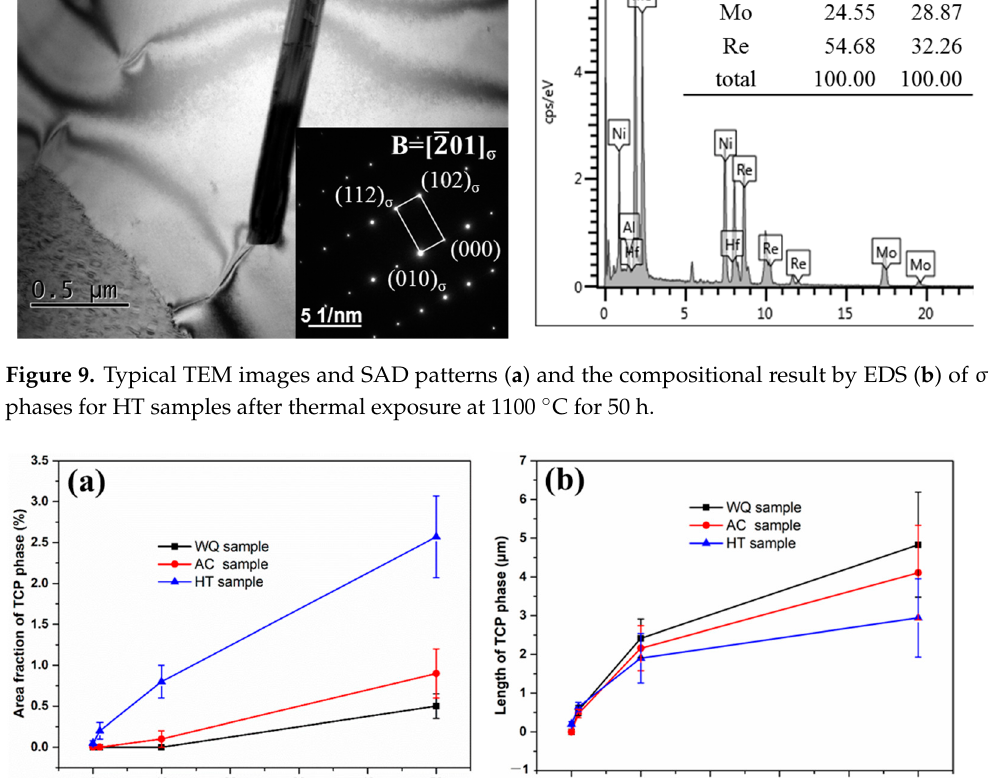
Figure 10. Area fraction ( a ) and length ( b ) of TCP phases of samples after different thermal exposure times.